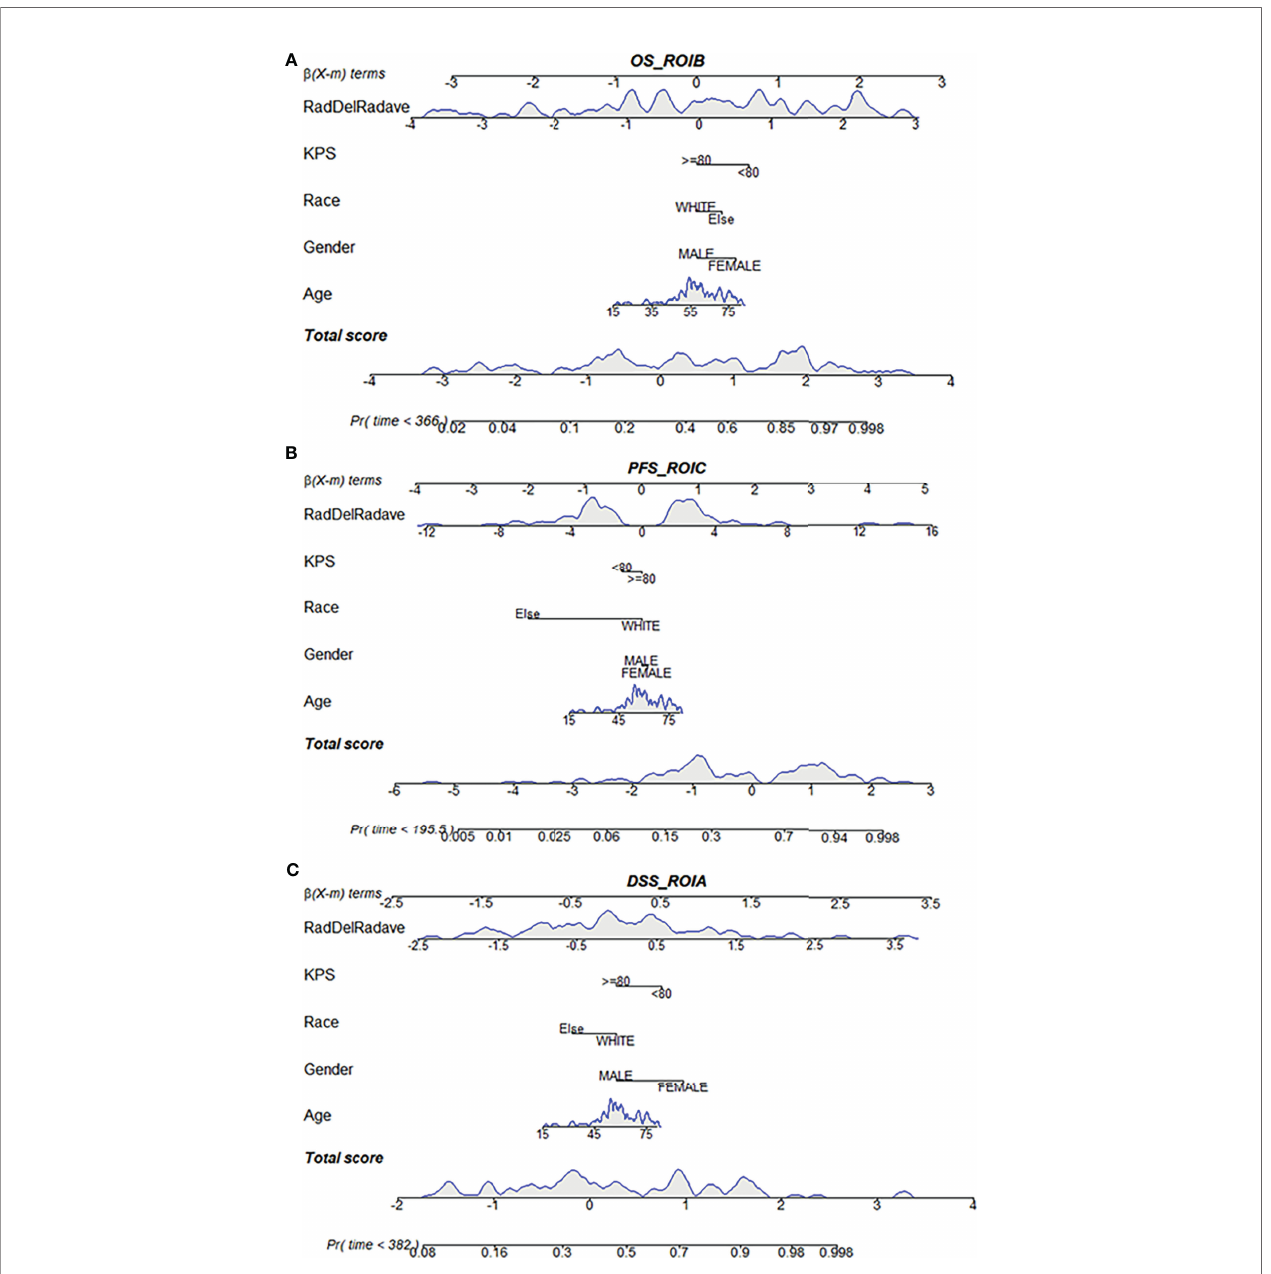
FIGURE 5 | Radiomics nomogram for the three survival indicator strati fi cation of GBM patients. The shaded part indicates the distribution status and probability density of the patients. (A) Represents the OS_ROI B model, (B) PFS_ROI C model and (C) DSS_ROI A model. DSS, disease-speci fi c survival; KPS, Karnofsky Performance Scale; OS, overall survival; PFS, progression-free survival; ROI, region of